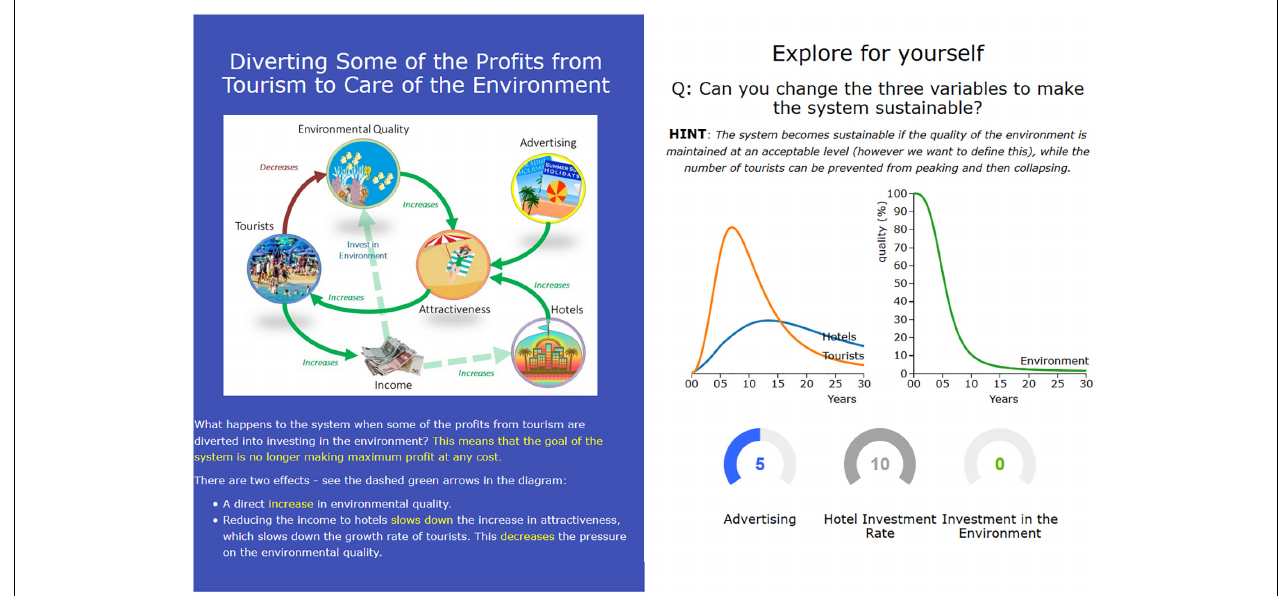
FIGURE 5 | OL tool screenshot: illustration of changing the system structure for sustainability, and a simulation giving users an opportunity to practise bringing the system into a sustainable state by manipulating model variables (RQ3).